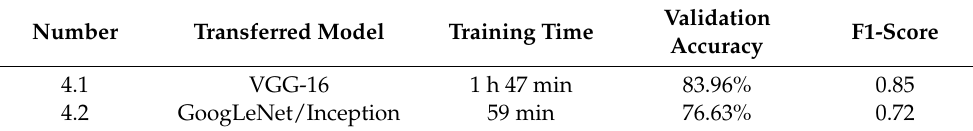
Table 7. Transfer learning with the ImageNet dataset using VGG-16 and GoogLeNet.